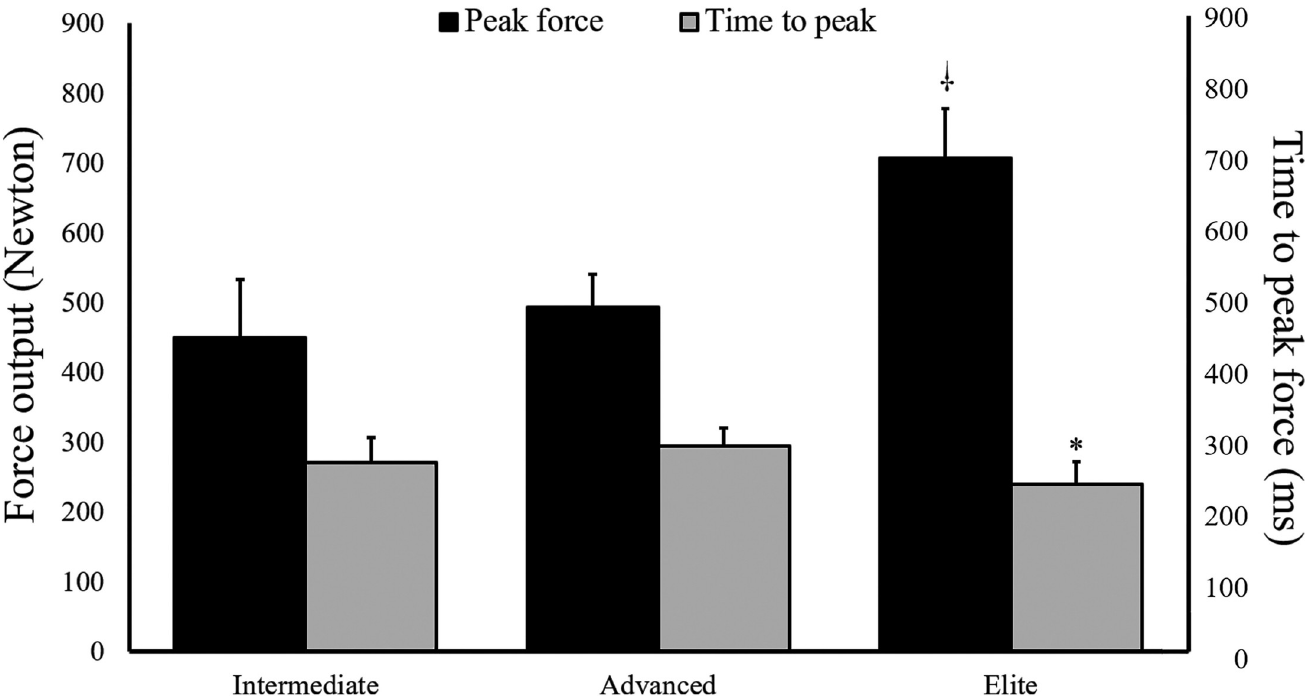
Fig 2. The maximal force output (Newton) and the time to reach peak force (milliseconds) for the three groups. † = significantly higher than the intermediate and advanced groups (P < 0.01). � = significantly lower than the advanced group (P < 0.01).